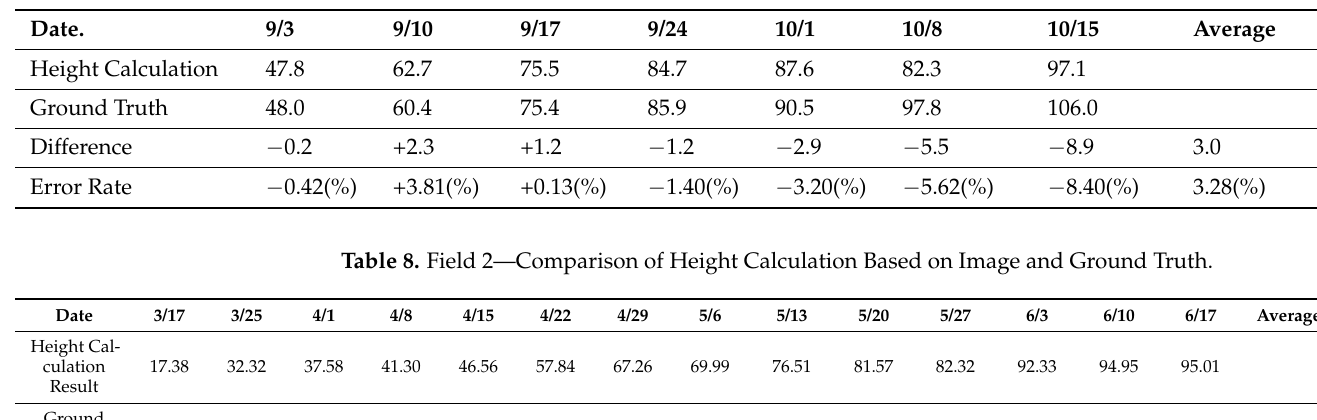
Table 7. Field 1—Comparison of Height Calculation Based on Image and Ground Truth.